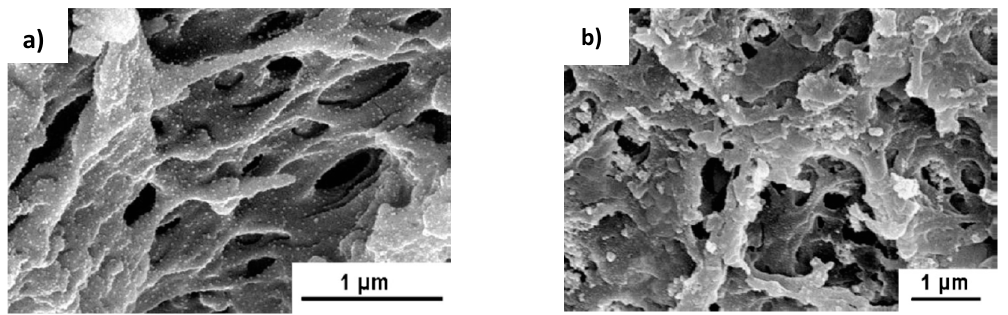
Figure 16. Morphology of PES-PSS / PAH / AuNPs before ( a ) and after ( b ) hydrogenation of 4-NP and percent reduction of 4-NP ( b ) after 3 h. (Reprinted from [60]).